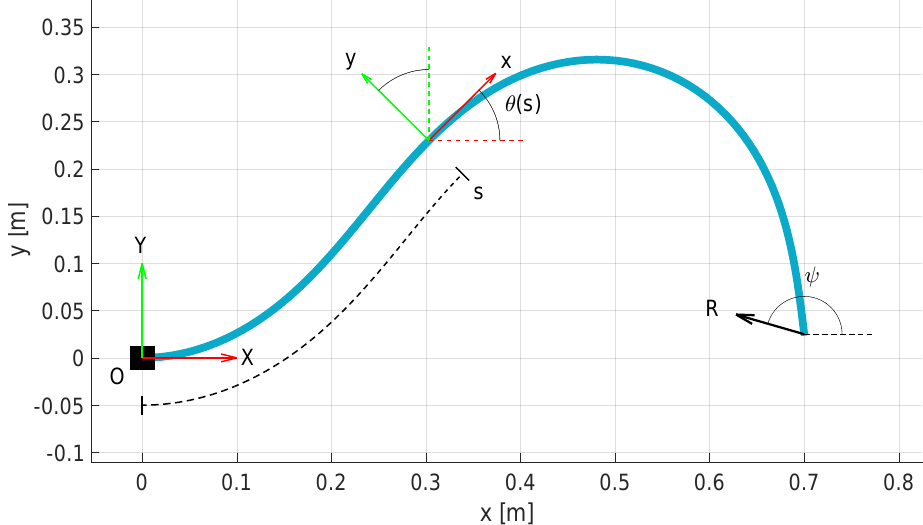
Figure 2. Deformed shape of a clamped-hinged planar rod under load R at